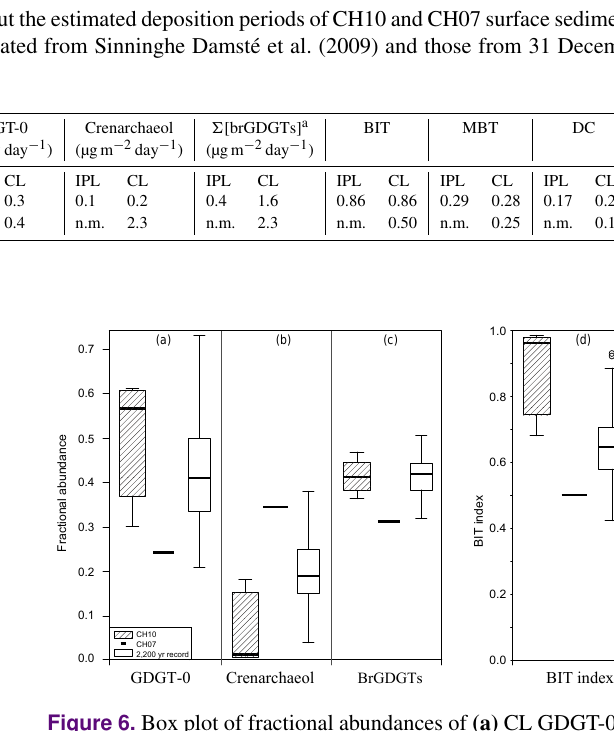
Figure 6. Box plot of fractional abundances of (a) CL GDGT-0 (I), (b) CL crenarchaeol V, (c) CL summed brGDGTs, and (d) the BIT index for surface sediments CH10 ( n = 7, 0–1cm depth) collated from Buckles et al. (2014), CH07 collated from Sinninghe Damsté et al. (2009), and the 2200-year sediment record (0–213cm depth at 1cm resolution, where 1cm represents on average 10.4 years of deposition). Note that surface sediments represent 2–3 years of deposition. The box corresponds to the interquartile range and the whiskers extend to 1.5 times the length of the box (unless the full range of data is smaller than this); outliers are defined here as being outside the maximum extent of the whiskers. The black horizontal line inside the box represents the